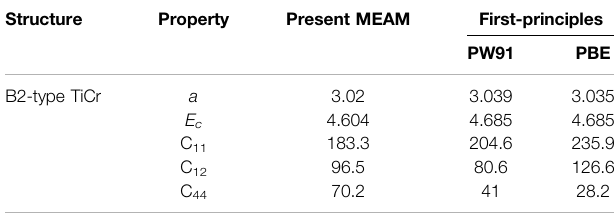
TABLE 3 | The 2NN MEAM interaction potential parameters for Ti-Cr-N ternary system. Parameter C min (Ti-Cr-N)